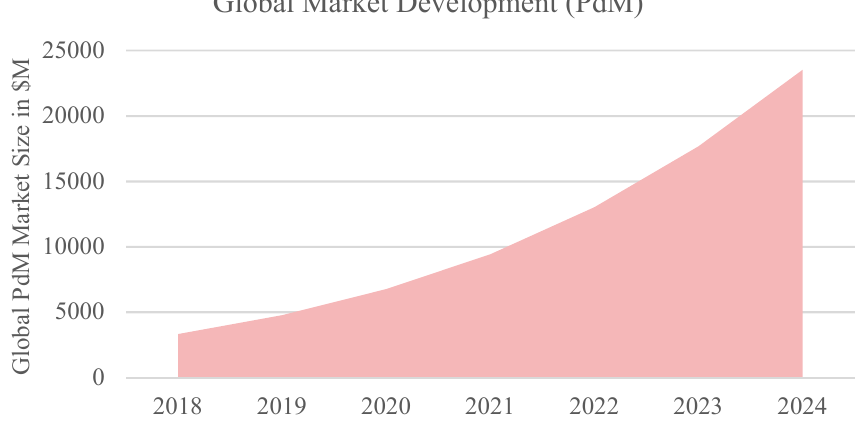
Figure 6. Importance of IA for business managers and data scientists. Adapted from [22].